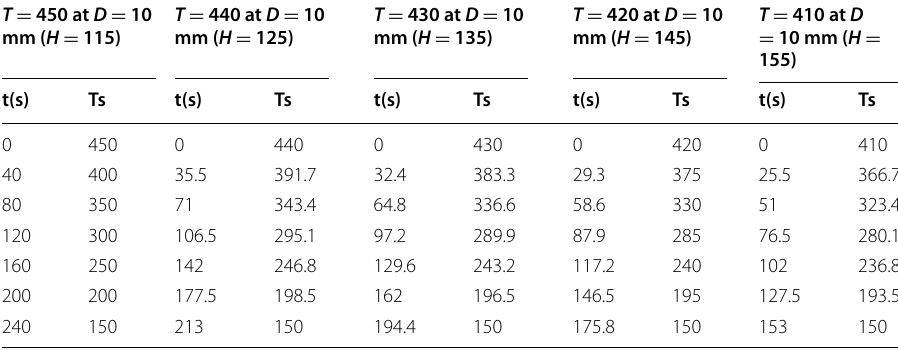
Table 2 150 °C at D 10 mm variant T and H for W-JIC = T 450 at D 10 = = mm ( H